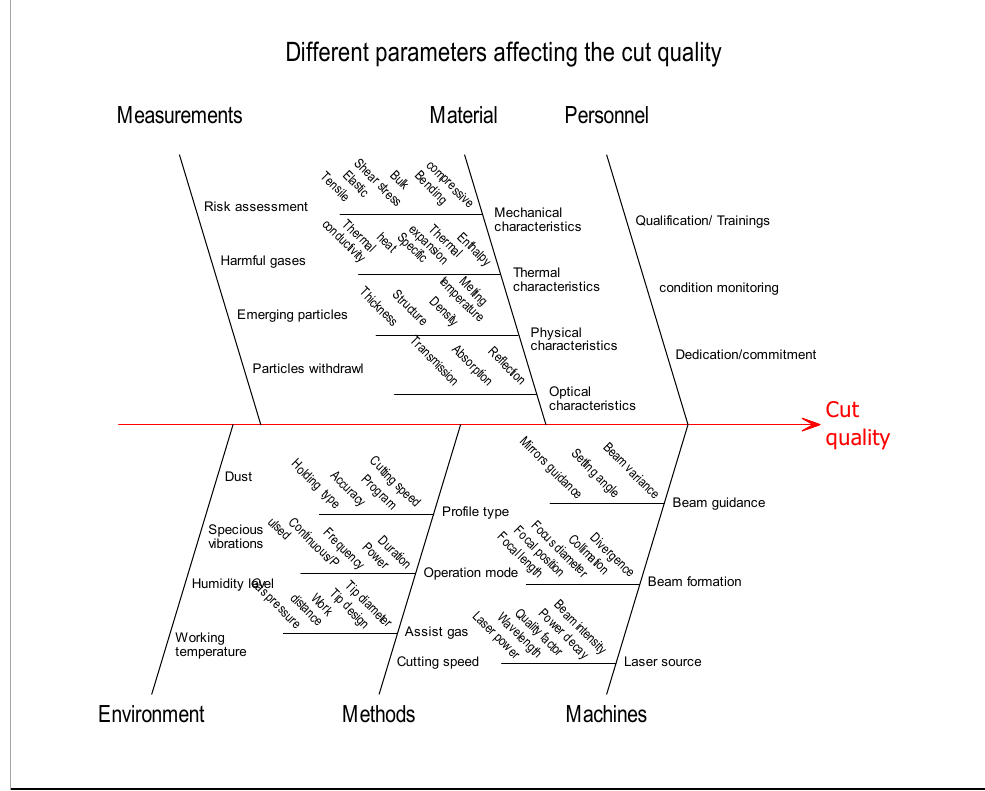
Figure 8. Cause and effect diagram to elaborate on the effect of different input parameters on output responses [44]. Materials 2020 , 13 , x FOR PEER REVIEW